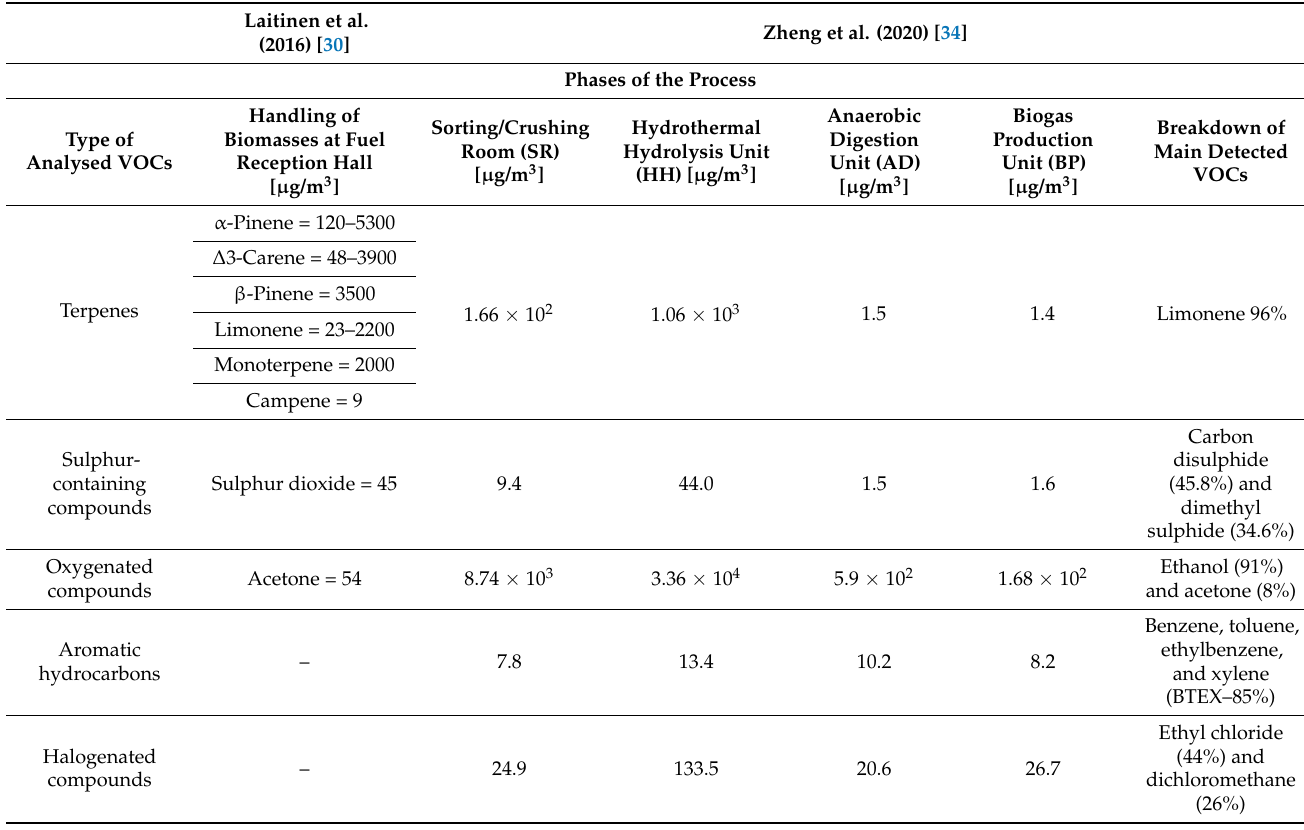
Table 7. Main detected VOCs identified as being originated from pine and spruce